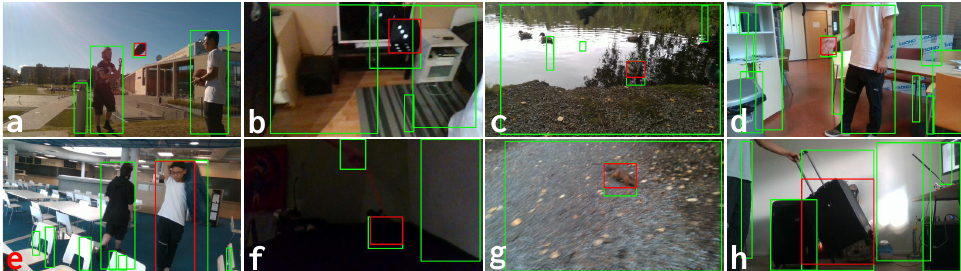
Figure 20. The results of our proposed obstacle tracking system on ( a ) ball10_wild, ( b ) cube03_indoor, ( c ) duck03_wild, ( d ) hand01_indoor, ( e ) human02_indoor, ( f ) pot_indoor, ( g ) squirrel_wild, and ( h ) suitcase_indoor video sequences of DepthTrack data set